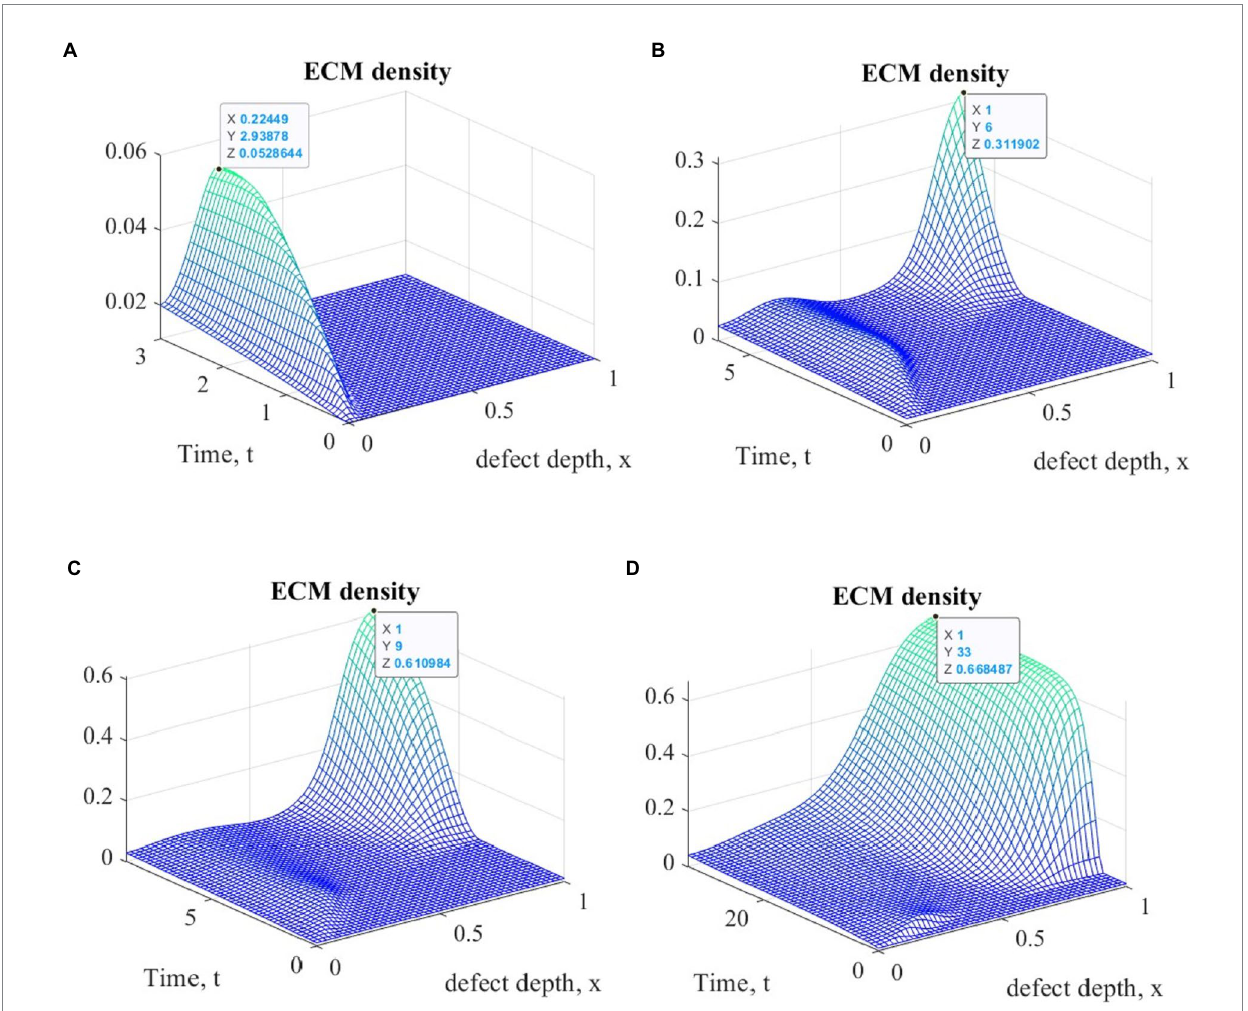
FIGURE 3 Graphs of ECM density changes at different time points during ASIT implementation: (A) t = 3 (~1 month); (B) t = 6 (~ 2 months); (C) t = 9 (~ 3 months); (D) t = 33 (~ 12 months).